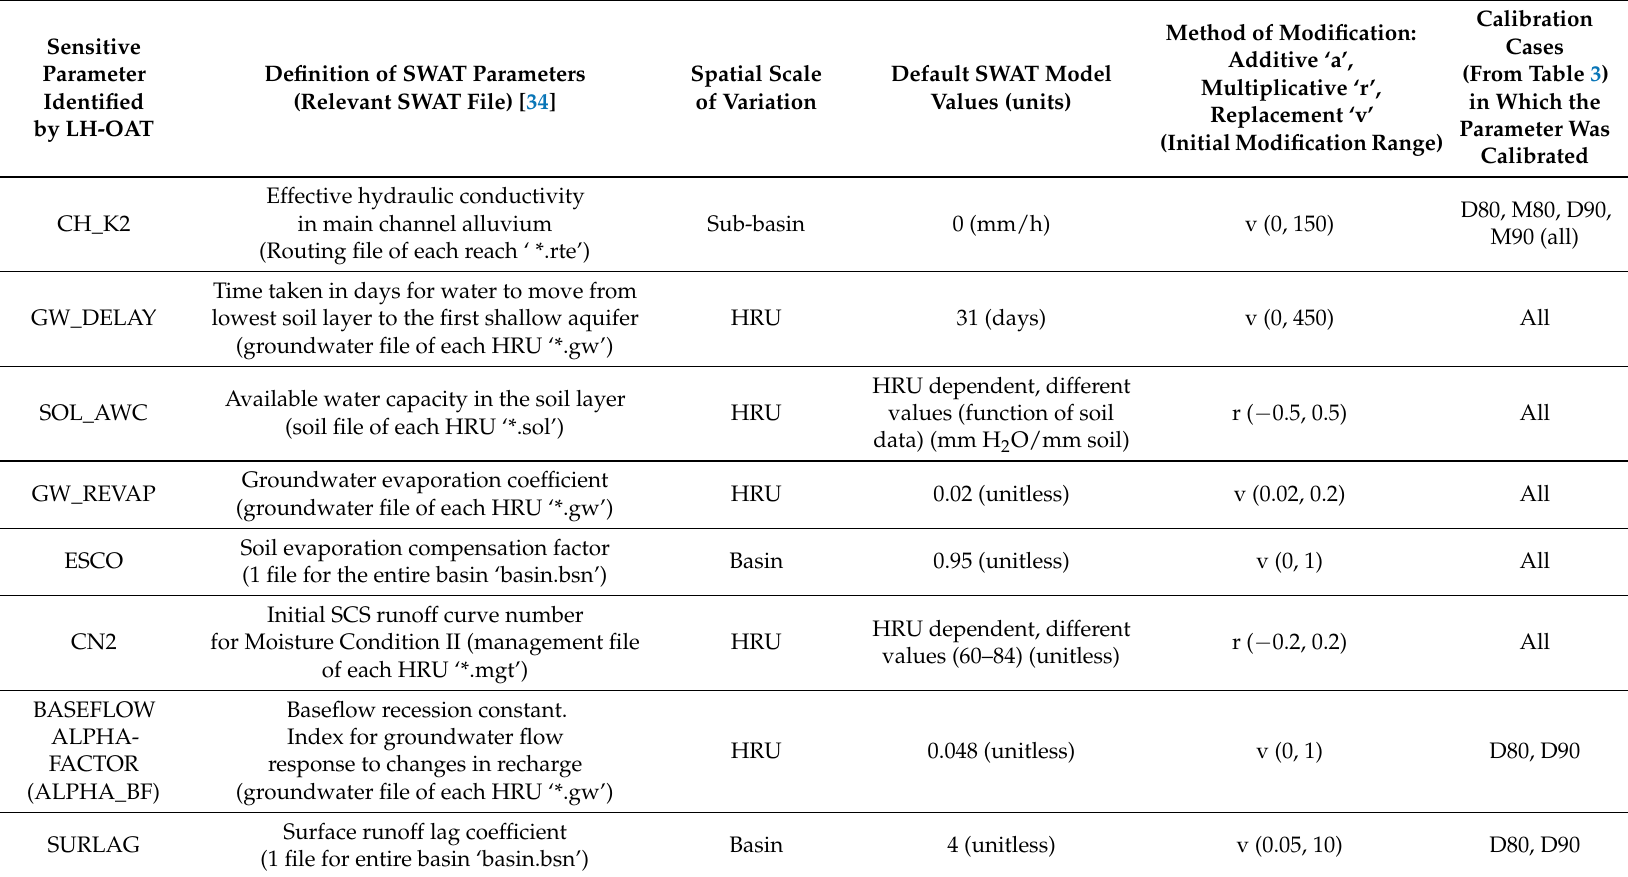
Table 4. Calibrated SWAT parameters, spatial scale of variation, default values, method of modification during calibration, and relevant calibration